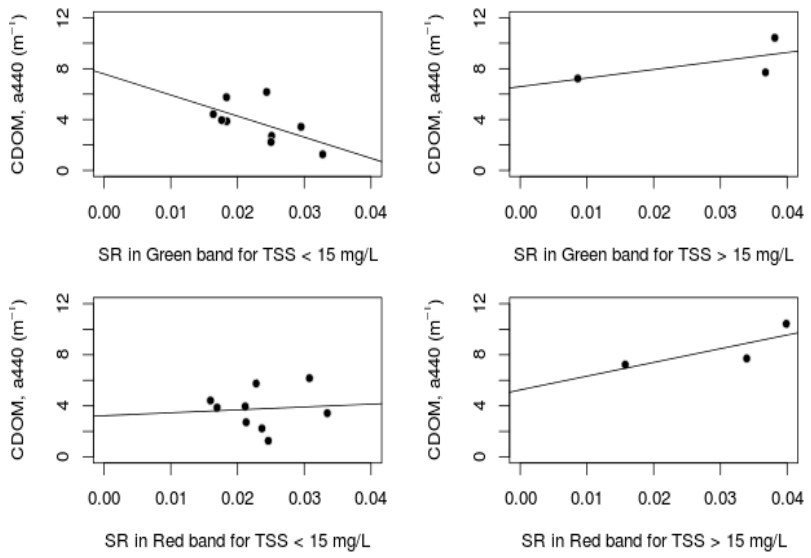
Figure 5. Statistical relationships between surface reflectance (SR) values in red and green bands and CDOM at 440 nm (m − 1 ) for the two groups of field sample observed from the histogram of frequency (Figure 4). For low or moderate TSS concentrations (TSS < 15 mg/L), the surface reflectance values in green are negatively correlated to CDOM whereas for high concentrations of TSS (TSS > 15 mg/L), the surface reflectance values are positively correlated to CDOM. In the red band, the surface reflectance values are positively correlated to CDOM for the two groups of field sample.